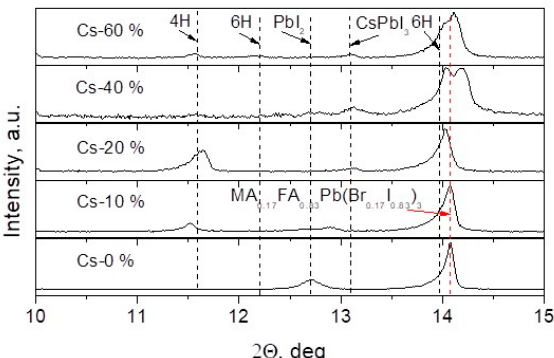
Figure 5. Fragments of XRD patterns of perovskite films formed with different concentration of Cs in the precursor solution.